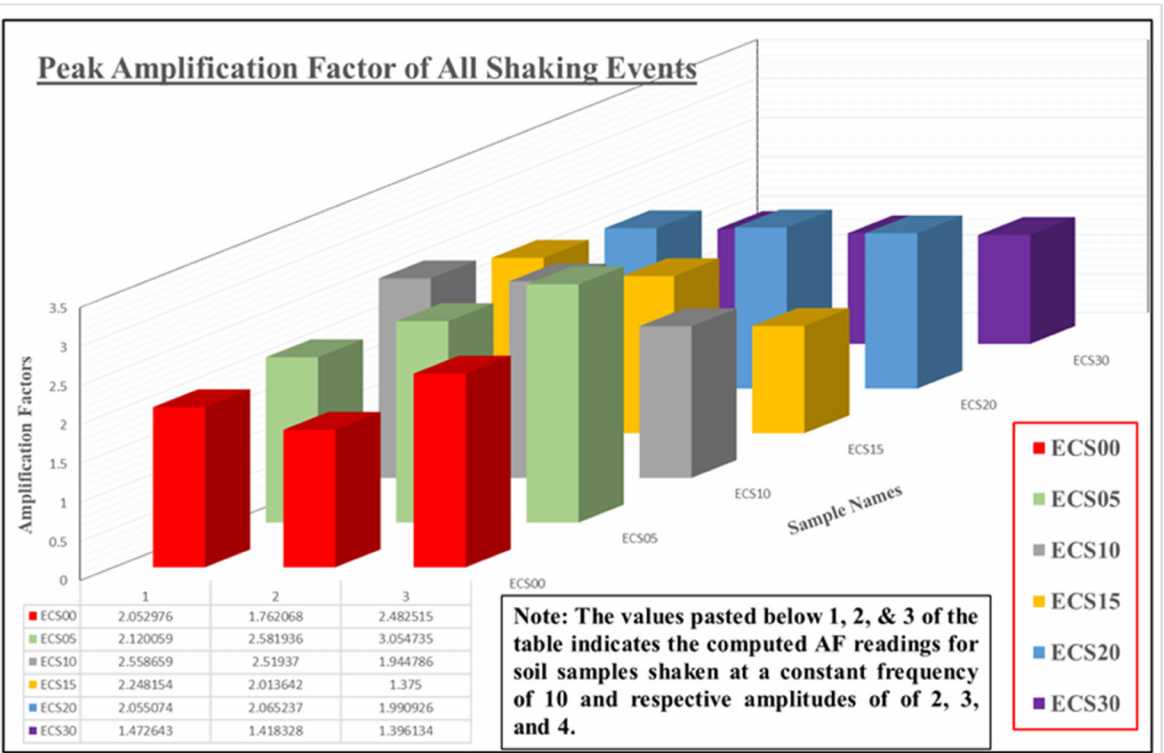
Figure 11. Statistical analyses of the amplification factors of all studied soil